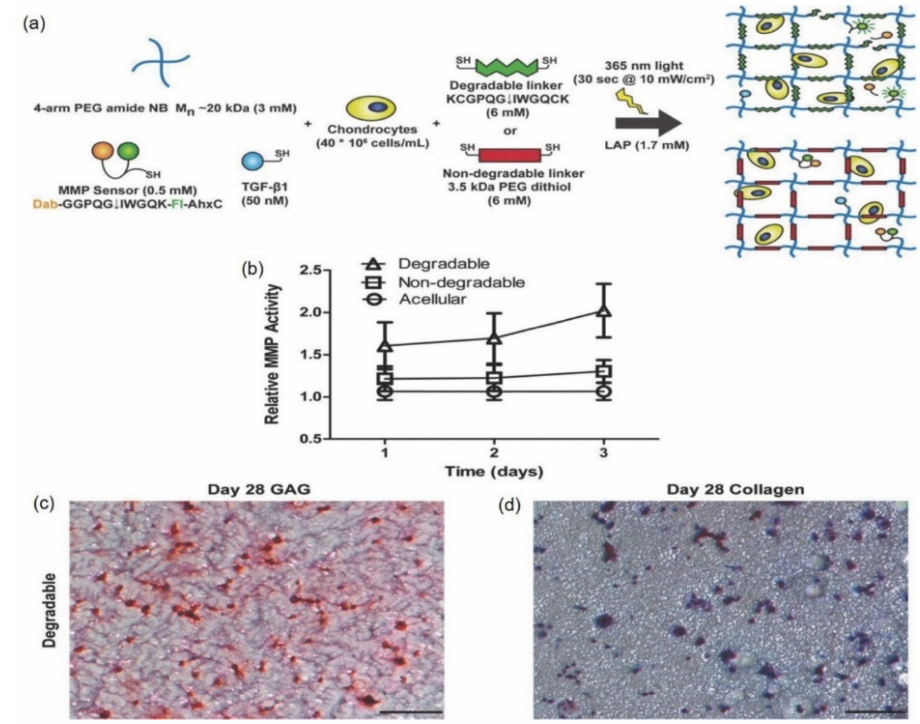
Figure 6. Schematic of MMP-degradable PEG hydrogel ( a , b ) prepared with a 4-arm PEG-norbornene network and MMP-degradable peptide sequence/or with non-degradable (3.5-kDa PEG dithiol) linker. The chondrocyte-laden degradable hydrogel maintained cell viability and significantly in- creased ( c ) GAG and ( d ) collagen deposition after 28 days of culturing. Adapted with permission from ref. [98], Copyright 2015 John Wiley and